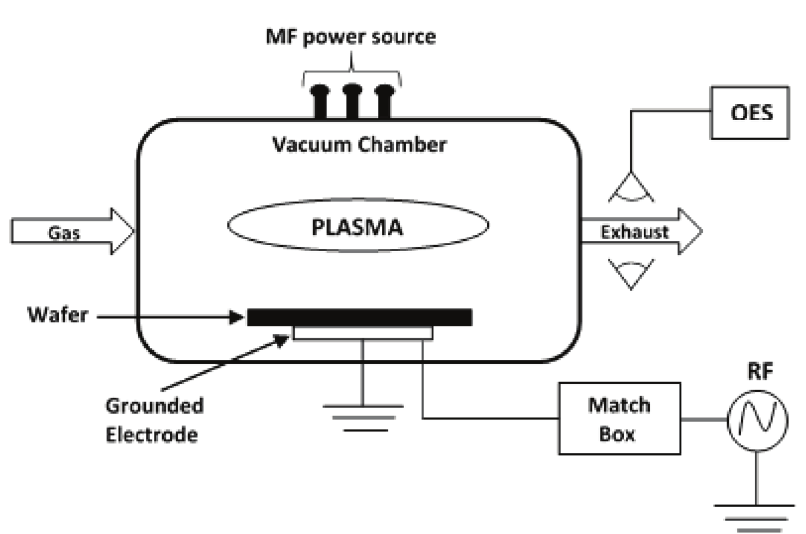
Fig. 2 – Flow diagram of a plasma etching